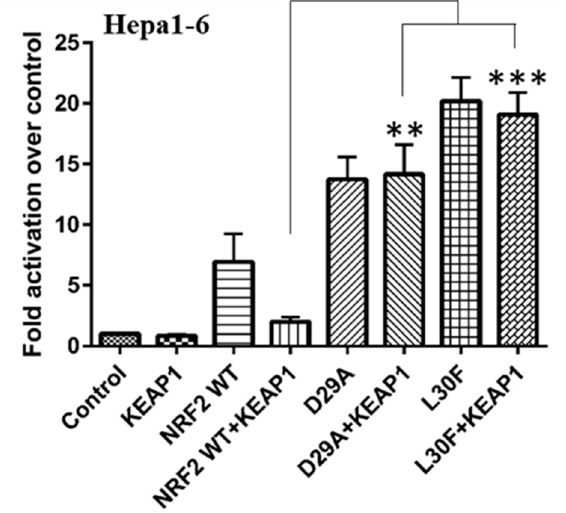
Figure 3. The effect of KEAP1 on NRF2 WT and MTs transcriptional activity in Hepa1-6 cells. The co-expression of KEAP1 inhibited the transcription activity of NRF2 WT but not of the D29A and